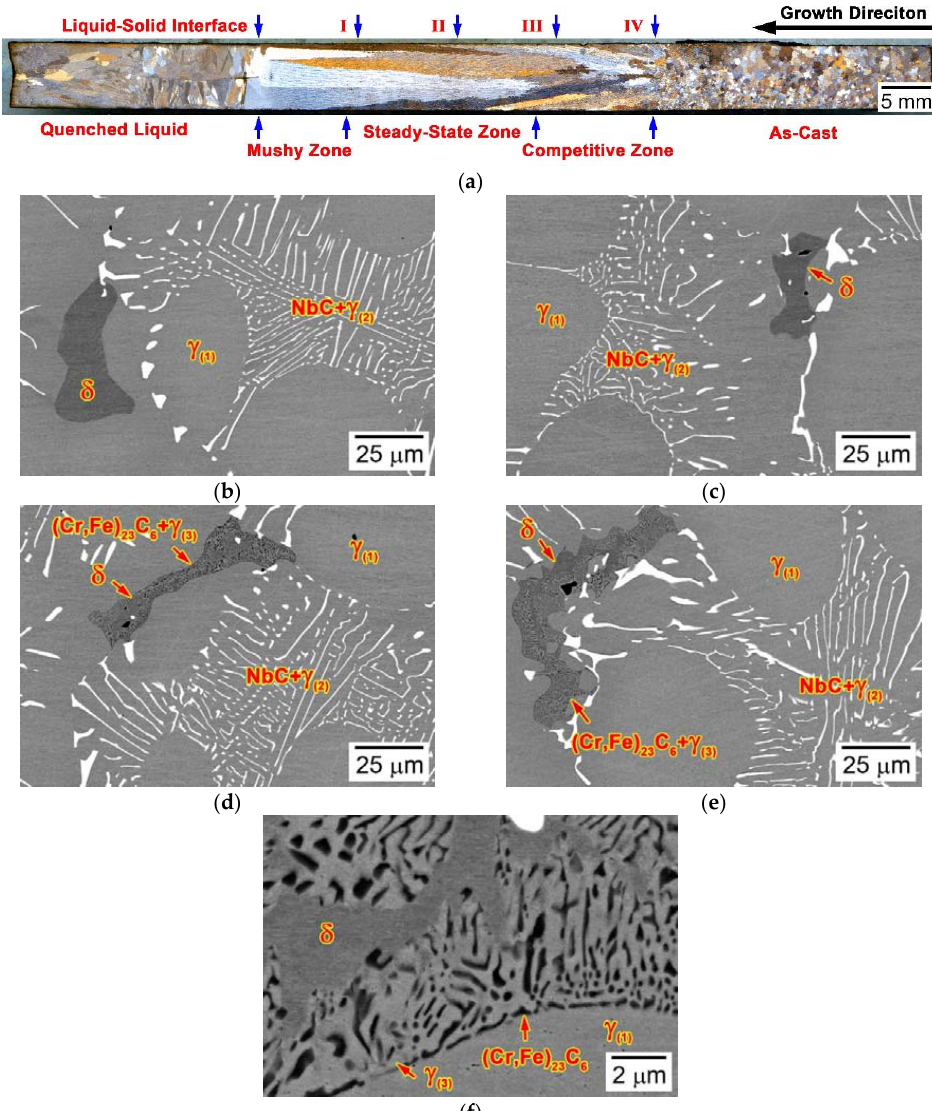
Figure 5. ( a ) Optical image of alloy 4C0N showing the liquid-metal quenched longitudinal macro-grain structure of the DS bar after the LMC-DS processing; SEM-BSE images were taken at distances of ( b ) 10, ( c ) 20, ( d ) 30, and ( e ) 40 mm away from the liquid-solid interface in Figure 5a, showing the microstructural evolution in the steady-state zone and the competitive zone; ( f ) is an enlarged SEM-BSE image of typical (Cr,Fe) 23 C 6 carbide and δ -ferrite acquired from Figure 5d.